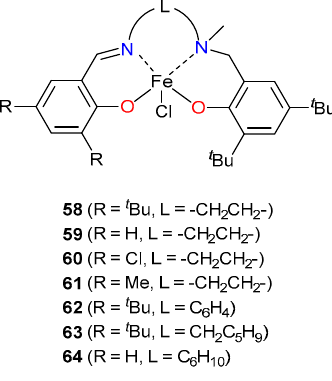
Figure 10. Salalen complexes 58–64 [54].